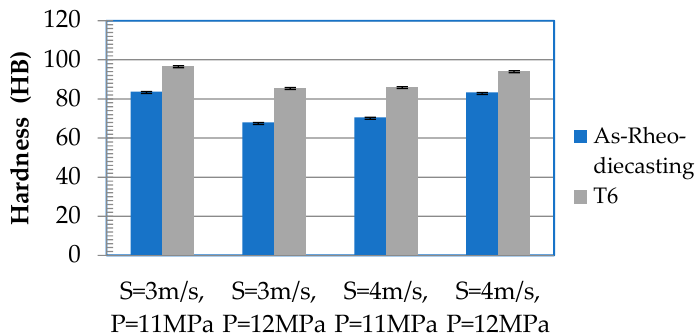
Figure 18. Average hardness of thixoformed A356 / SiC(15%SiC - 15µm). After T6, hardness values increased by 15 . 6% and 7 . 3% in the rheo-die-cast and thixoformed samples, respectively . This increase in hardness is due to the formation of Mg 2 Si precipitates during ageing inhibiting dislocation movement . The presence of particulates may modify vacancy contents, facilitate diffusion of solutes and provide additional sites for the heterogeneous nucleation of precipitating phase [ 22 ]. In addition, the SiC can modify the morphology of eutectic phase . The morphology of Al - Si eutectic formed by rheo - die-casting and thixoforming also are refined and modified from needle - like to more globular, as shown in Figures 19 and 20 . Figure 19. The microstructure of rheo-die-cast A356 / SiC ( 15%SiC - 15µm ) in T6 condition .